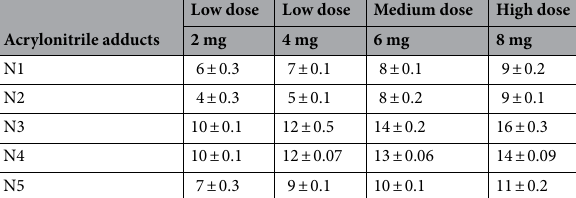
Table 2. Zone of inhibition (mean standard error) for B. subtilis .